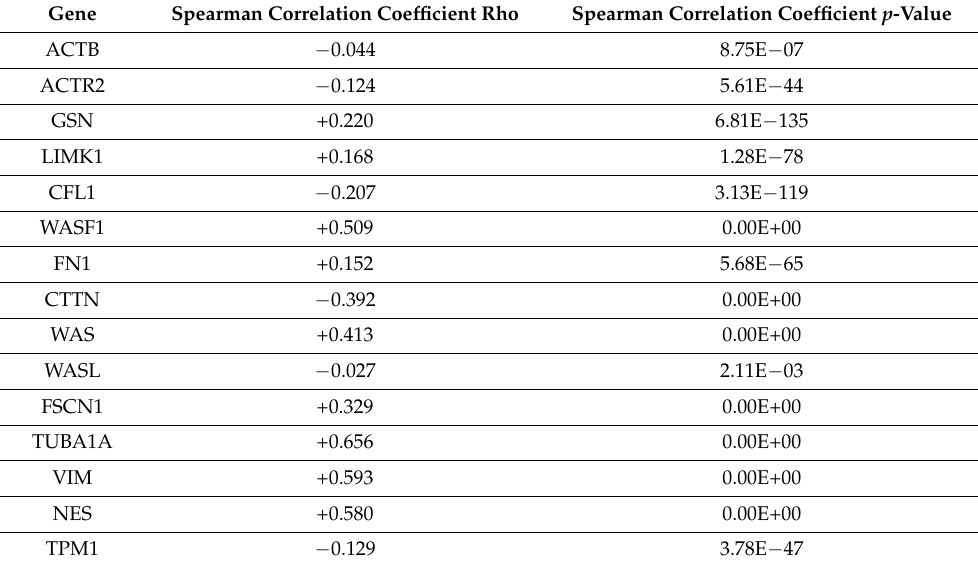
Table 1. Correlation (Rho) of cytoskeleton genes expression (FPKM) with EMT score in clinical samples (TCGA cohorts, n = 12,290.) A higher Rho indicates that a sample has more mesenchymal- like phenotype, whereas a lower Rho indicates that a sample has a more epithelial-like phenotype. The correlation significance was assessed using the Spearman correlation coefficient